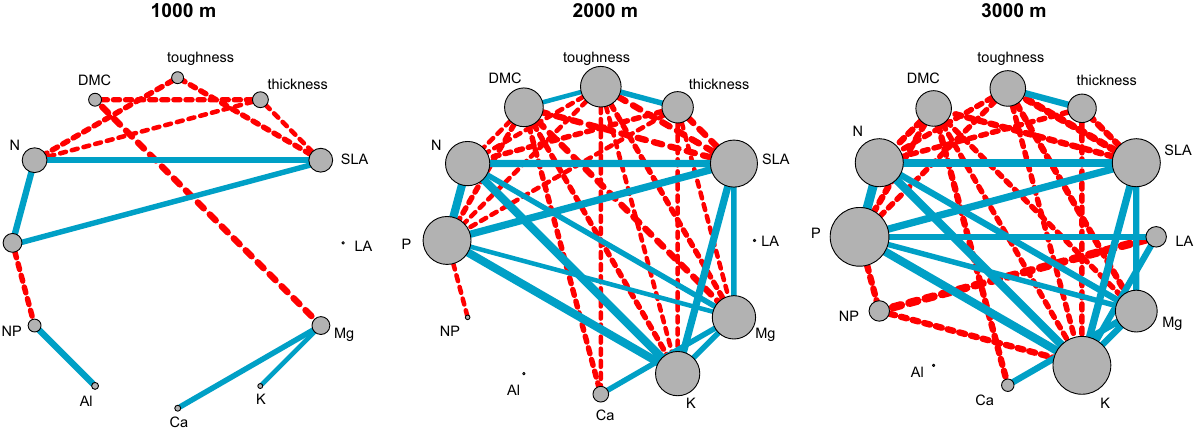
Figure 5. Leaf trait networks for the three study sites (from left to right: premontane, lower montane and upper montane forest). Only significant correlations ( p < 0.05) are shown. Solid blue lines and dashed red lines show positive and negative correlations, respectively. Line thickness represents the strength of the correlations. The size of the trait nodes gives the sum of the weights of edges linked to a focal node (“node strength”).